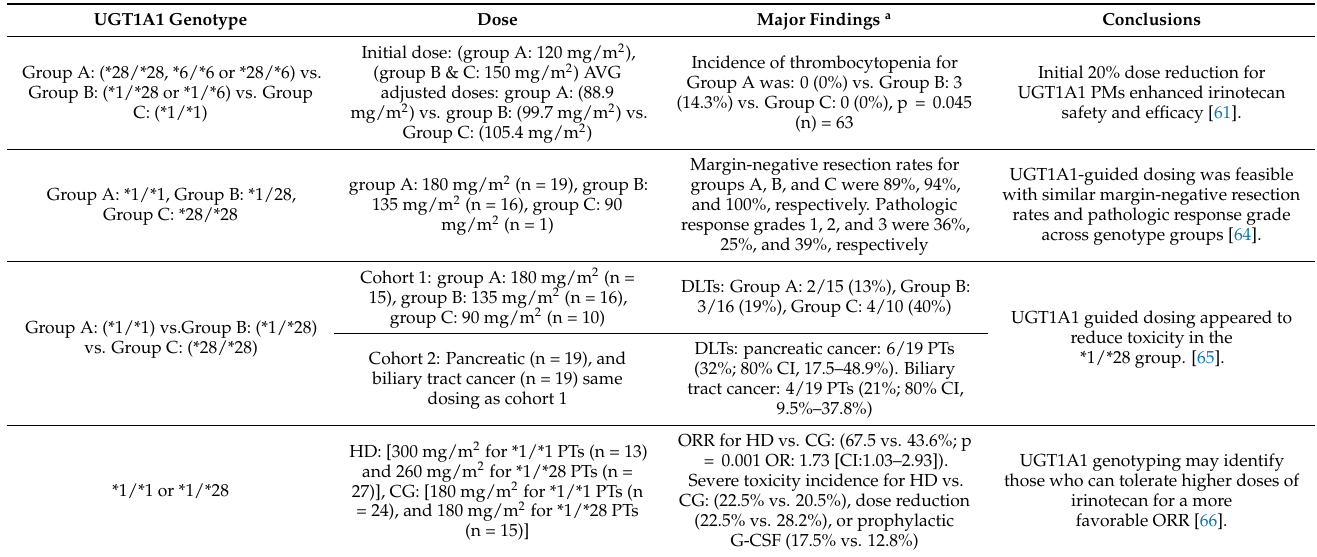
Table 3. Prospective studies investigating safety and efficacy of UGT1A1 guided irinotecan